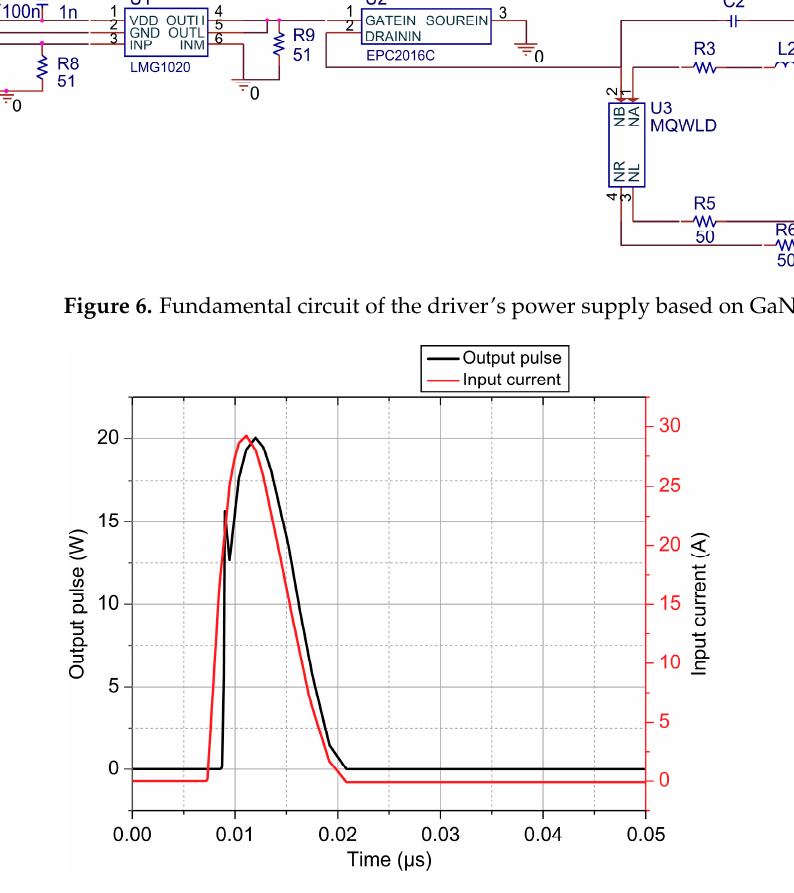
Figure 7. Laser-input current and output pulse waveforms.